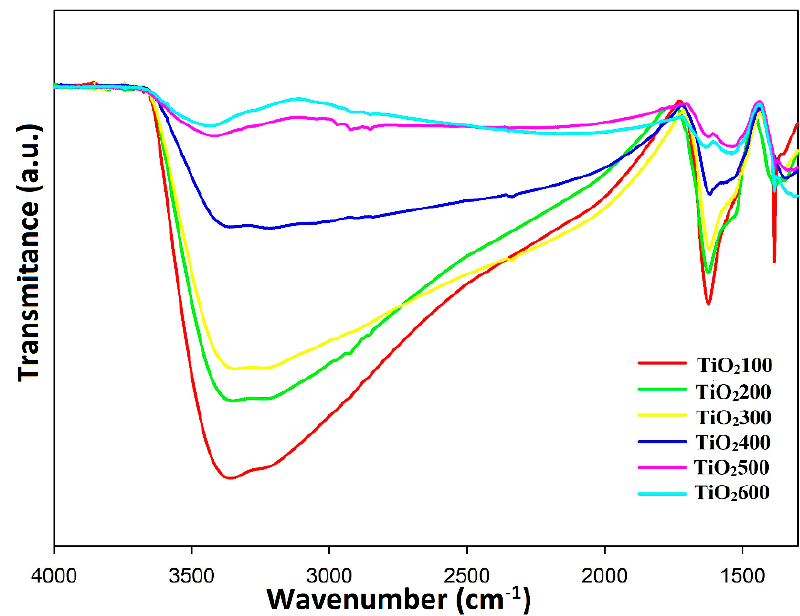
Figure 1. FTIR spectra of TiO 2 samples.